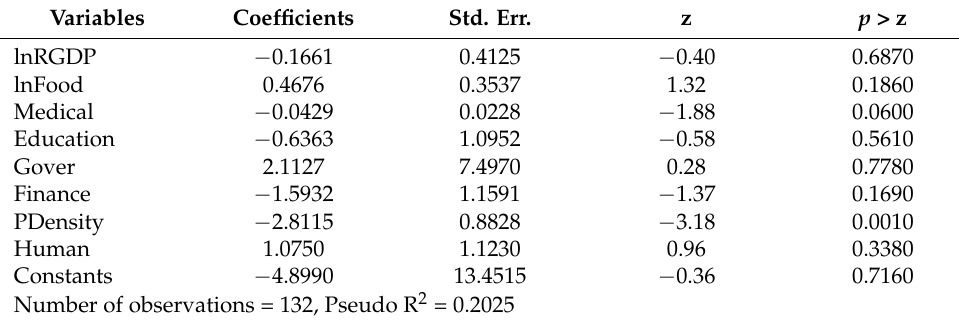
Table 4. Probit regression results of propensity score matching.